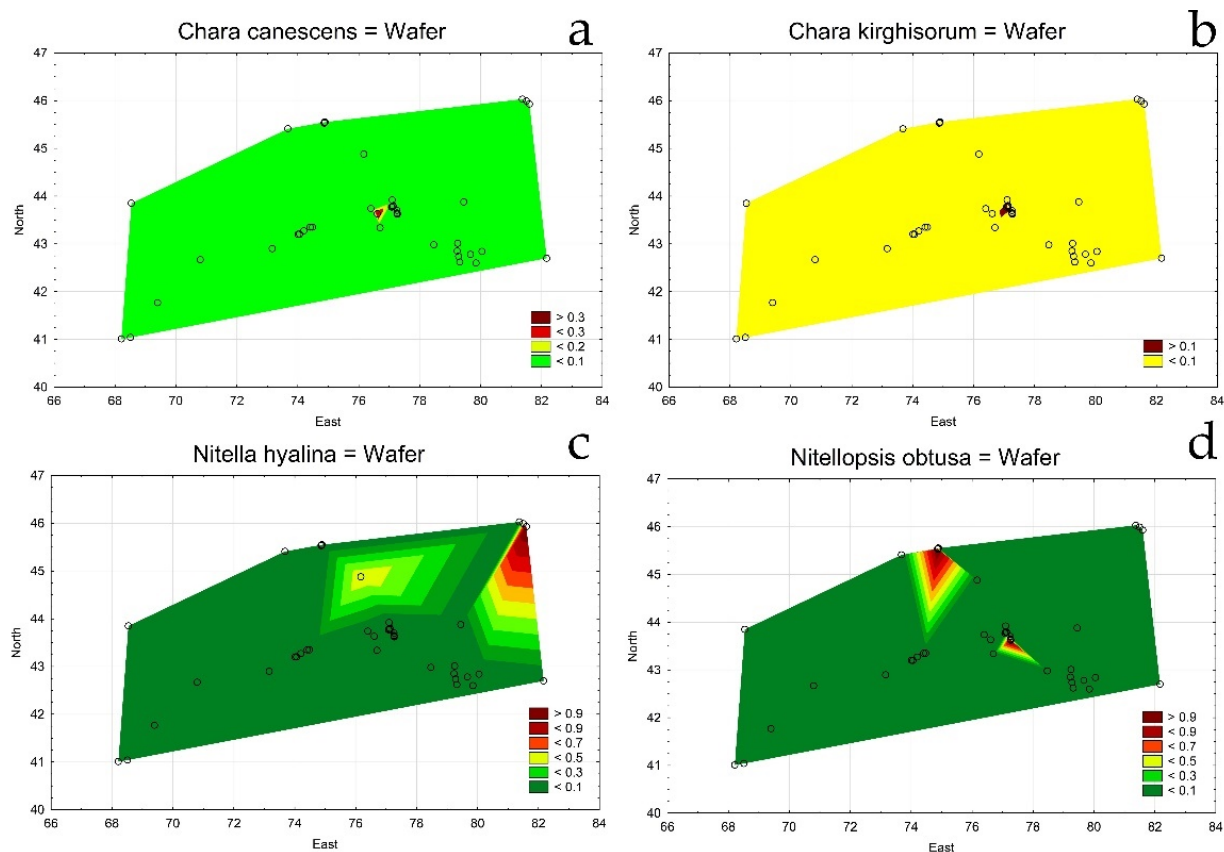
Figure 4. Statistical maps for species distribution on the studied area of south and southeast Ka- zakhstan in 2019–2022. Chara canescens ( a ); Chara kirghisorum ( b ); Nitella hyalina ( c ); Nitellopsis obtusa ( d ). The legend key shows the species relative value.